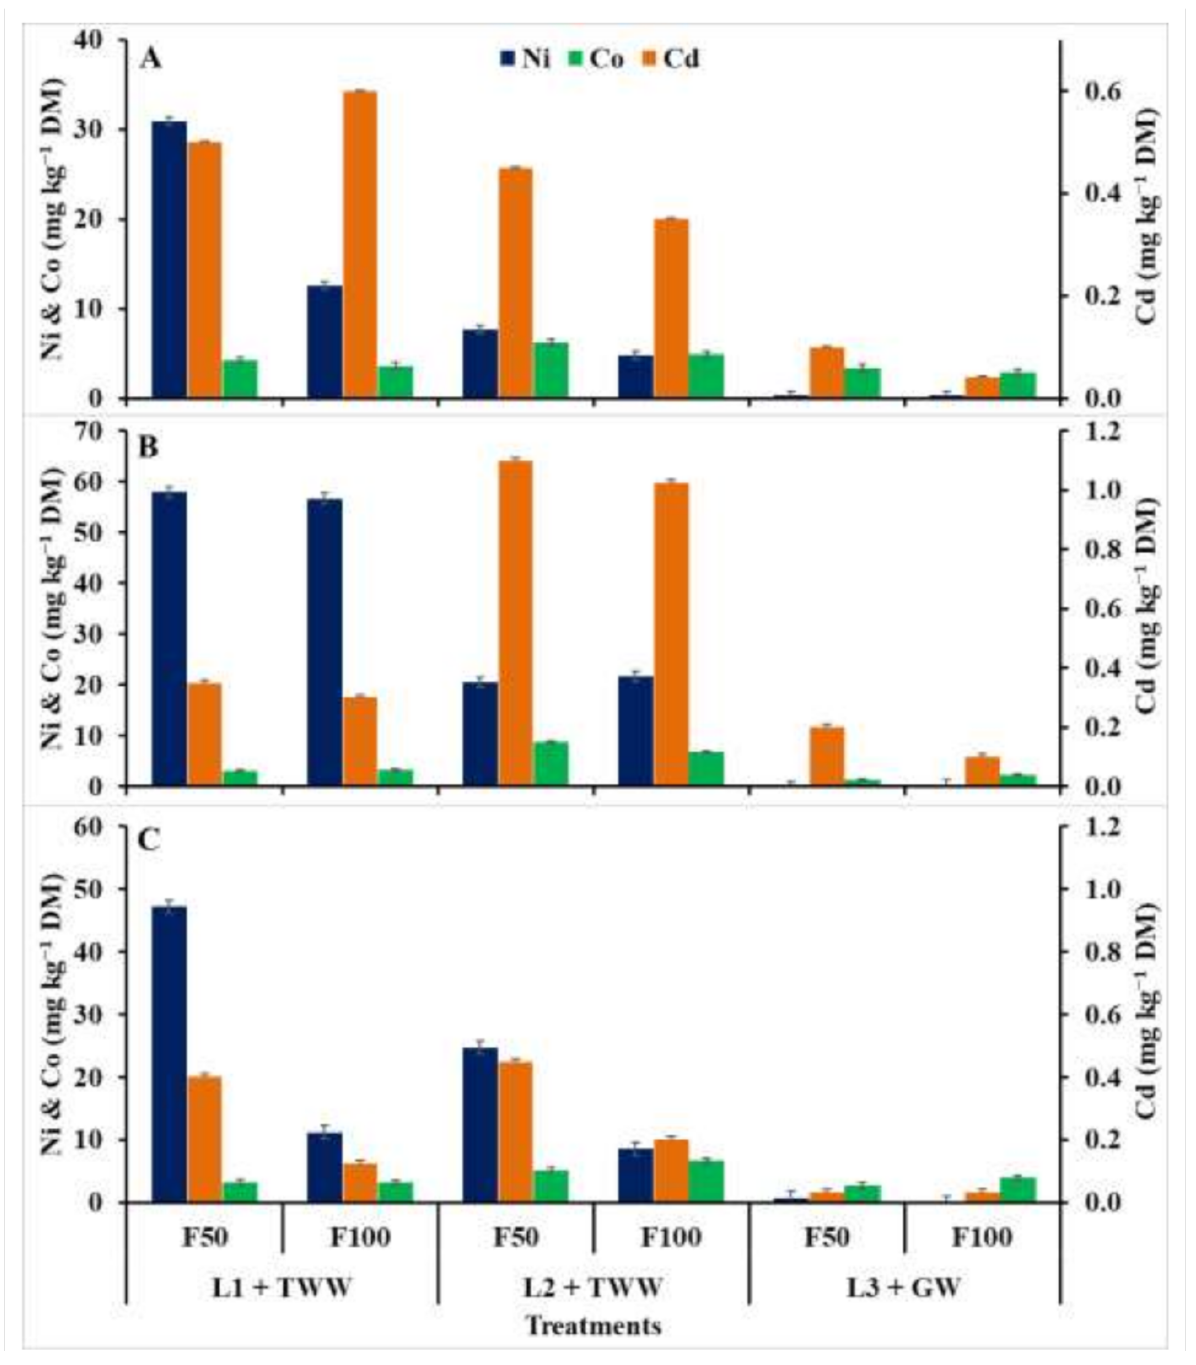
Figure 3. Interaction effects of water resources and fertilization treatments on Ni, Co, and Cd in maize ( A ), sorghum ( B ), and pearl millet ( C ). Error bars = Standard error of means (S.E.M.). L1 + TWW = Old soil + Wastewater; L2 + TWW = Virgin soil + Wastewater; L3 + GW = Virgin soil + Groundwater; F50 and F100 are 50% and 100% NPK of the total recommended dose,